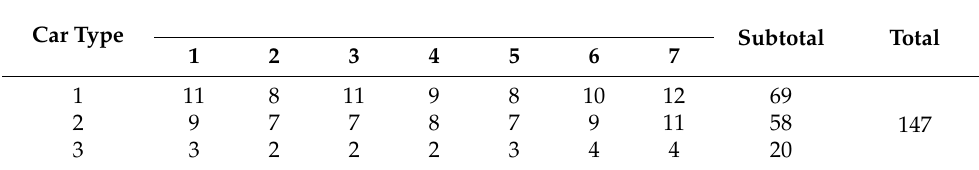
Table 12. Real demand in the fourth presale lead time interval.